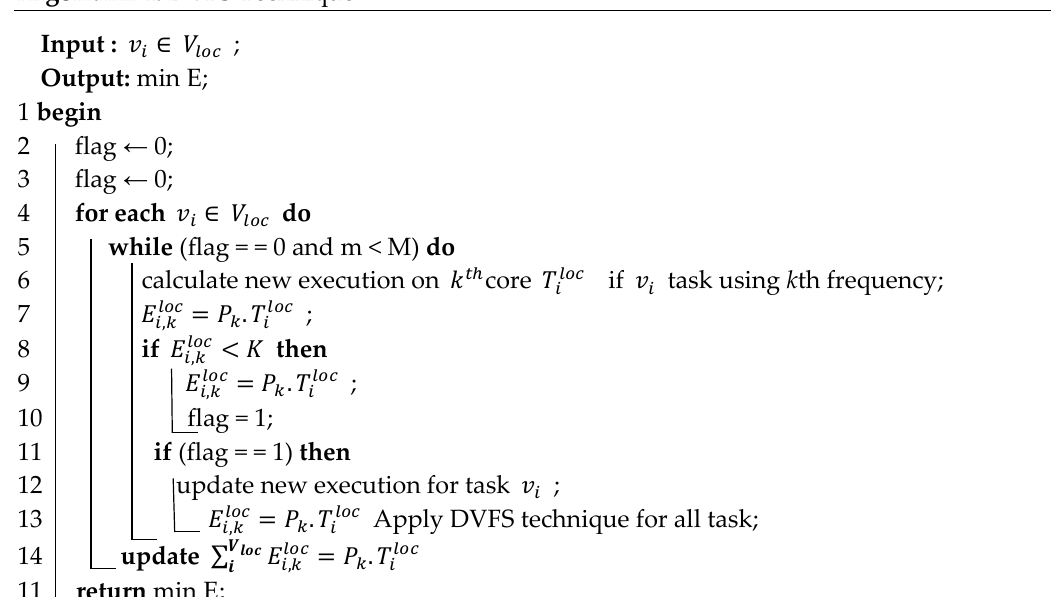
Algorithm 4: DVFS Technique